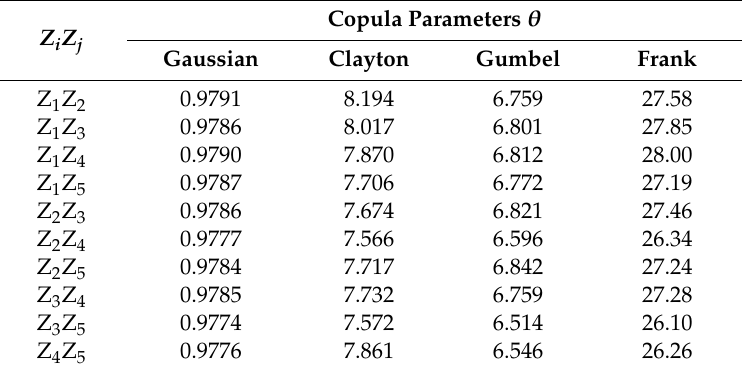
Table 5. The copula parameters for the candidate copulas.